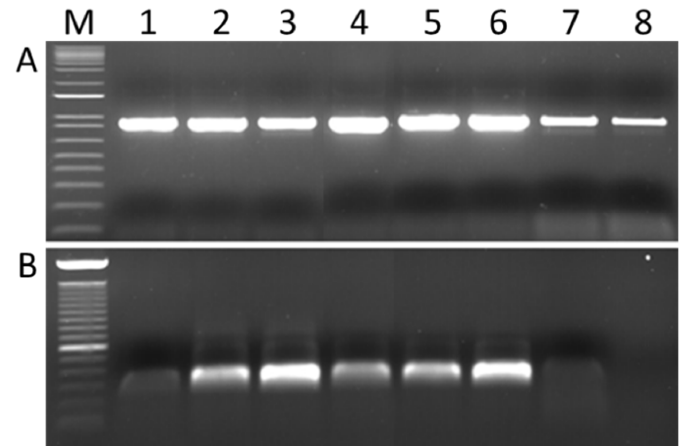
Figure 2. Detection of ( A ) GaJV-1 and of ( B ) fungal ITS sequences from total nucleic acids from grapevine leaves. (A) RT-PCR amplification of GaJV-1 RNA5 using the GaJV-1 RNA5F/RNA5R primer pair. ( B ) PCR amplification of fungal ITS sequences using the ITS1F-ITS2 primer pair. M, molecular weight markers ladders. Lanes 1 to 3, amplification from young grapevine leaves. Lanes 4 to 6, amplification from old grapevine leaves. Lanes 7 and 8, amplification from young grapevine